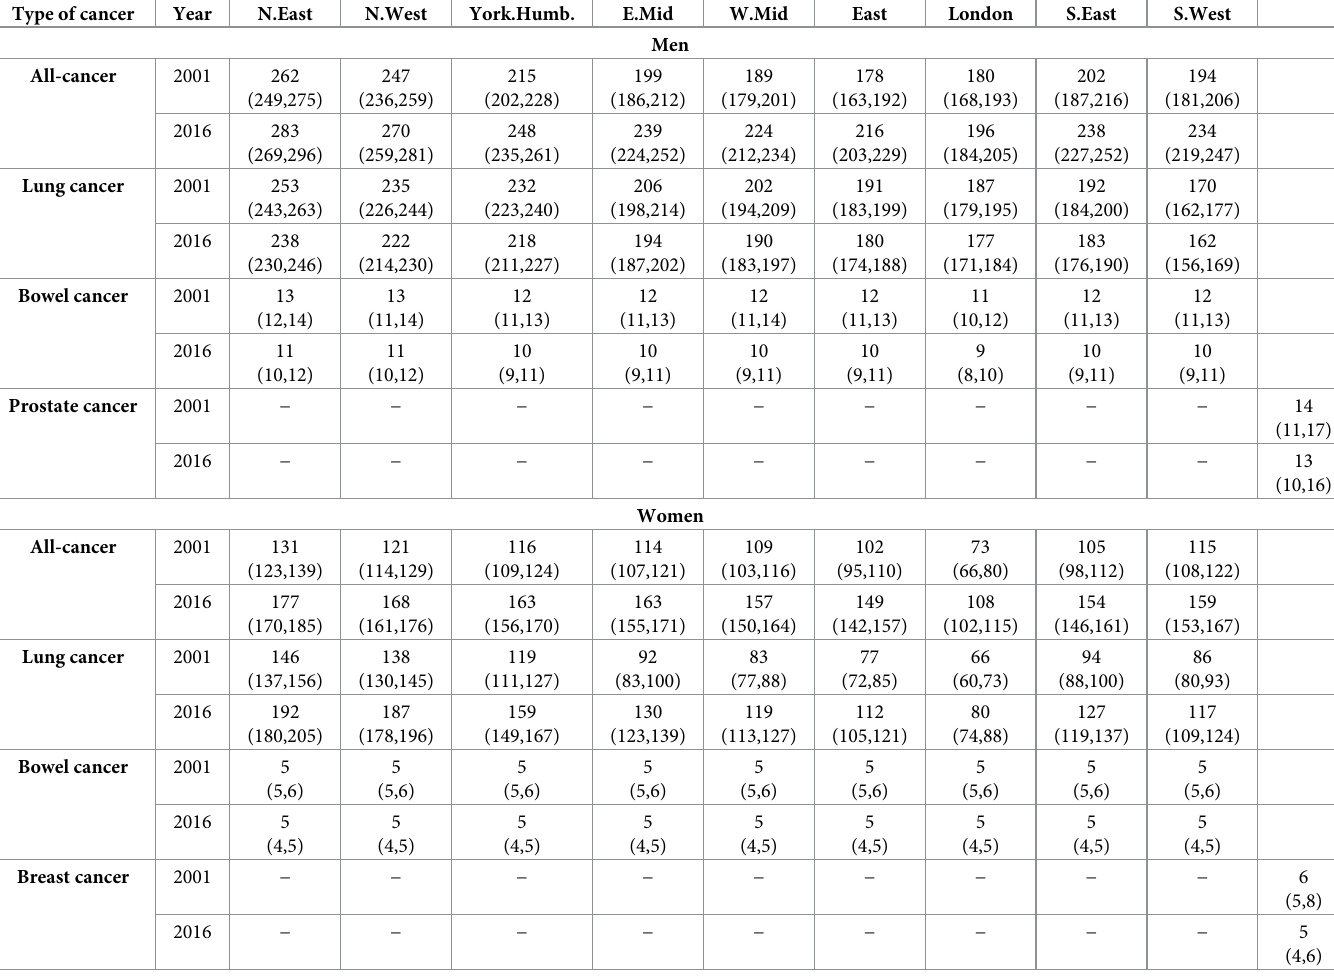
Table 7. Absolute deprivation differences (AD t , r ), per 100,000 people, in age-standardised fitted mortality rates in 2001 and 2016 for all regions in England and both genders; 95% credible intervals in brackets. Type of